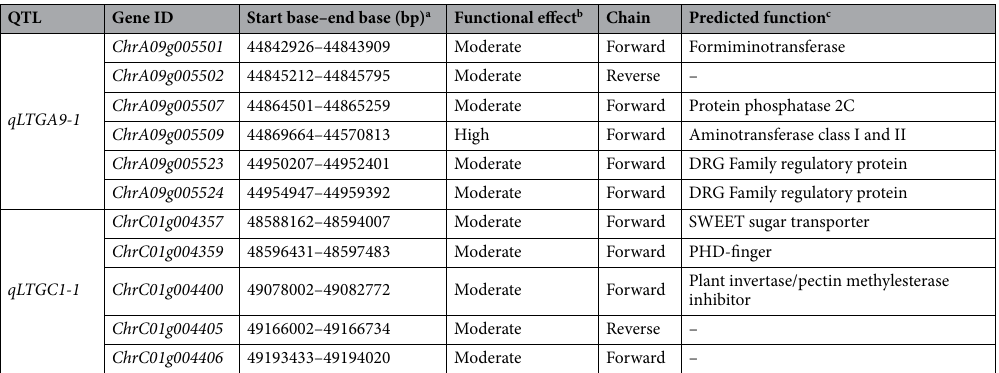
Table 5. Annotation of the candidate genes with moderate (high) effect variants in qLTGA9-1 and qLTGC1-1 regions. a Physical position of predicted gene obtained from the reference genome of Ningyou7. b Functional effects of variants (moderate or high) determined by snpEff tool. c Predicted function of candidate gene based on Ningyou7 annotation information. “–” indicates no putative conserved domains have been